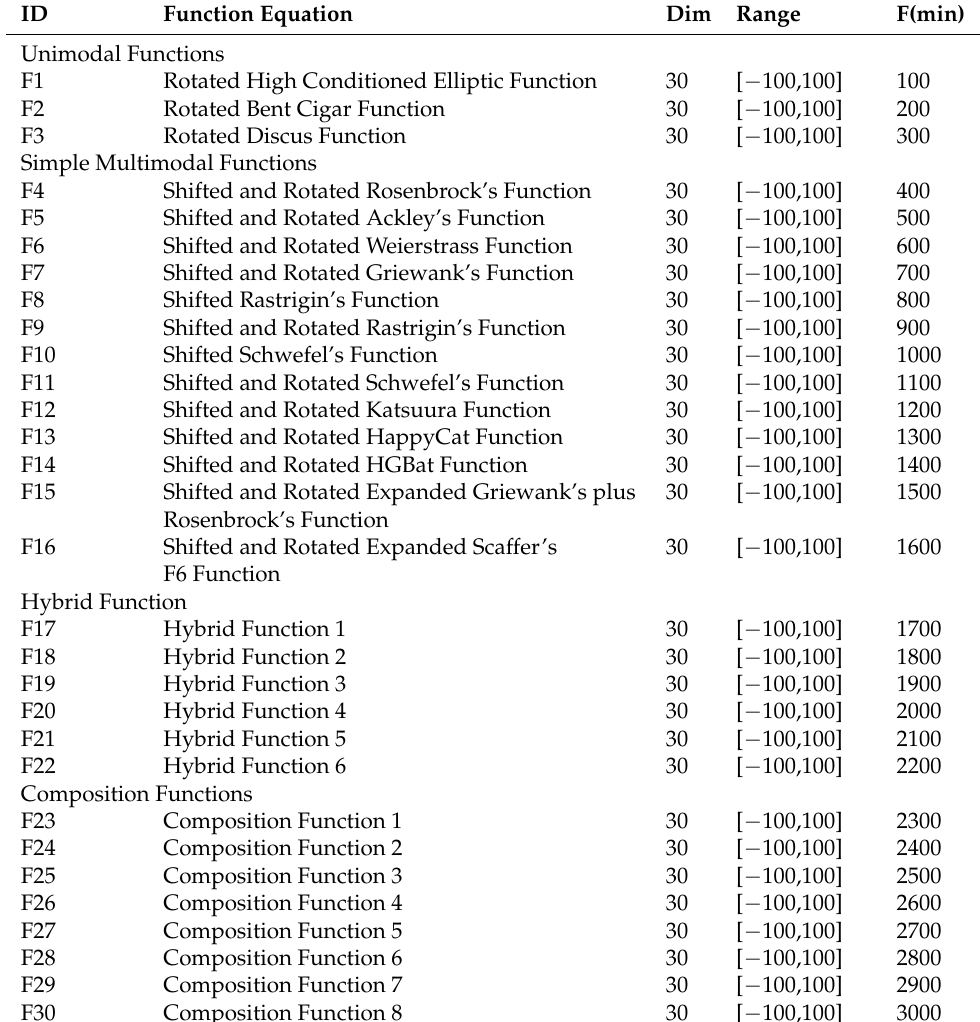
Table A1. Test benchmark